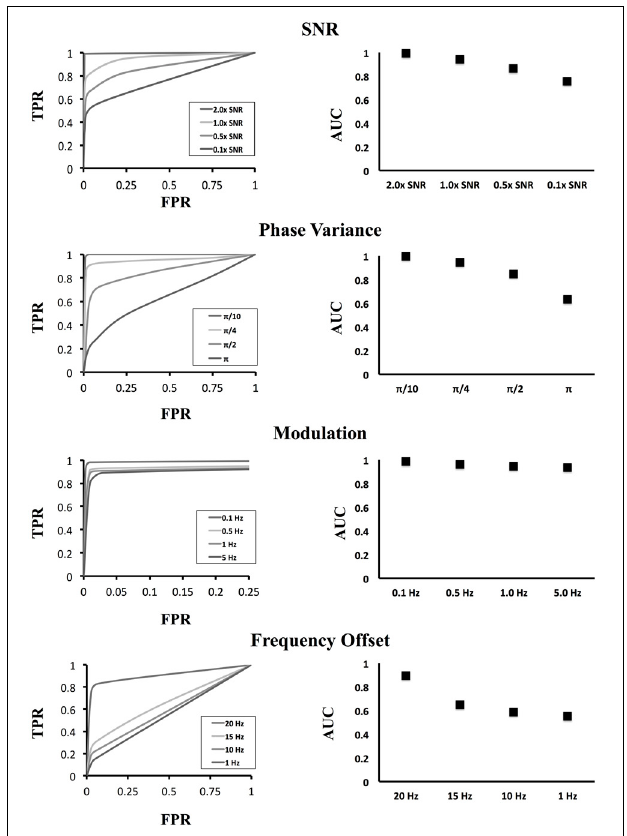
FIGURE 8 | ROC curves for various signal modulations. The left column shows the ROC curve for different settings of the simulation while the right column shows the area under the curve at those settings. In the top row, the resolution ability of our method falls as the SNR of the sinusoidal generator decreases. In the second row, we varied the instantaneous phase of the simulated sinusoid with the addition of noise from a uniform distribution. Increasing instantaneous phase variations caused the original sinusoid to degrade resulting in a loss of significant cluster resolution. In the third row, low frequency modulations were added to the signals with very little effect upon the outcomes owing to the time-frequency methods employed. In the last row, sinusoids in the two activated areas were generated using different sinusoidal frequencies. One area was fixed with a frequency of 25Hz. At the nearby frequency of 20Hz, we can distinguish connections between the regions; however, as the two frequencies diverged, the wavelet envelope degrades and we can no longer recover significant